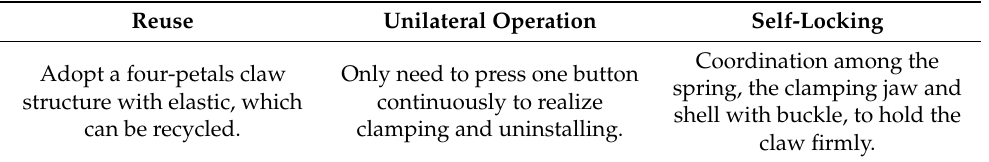
Table 4. Advantages of